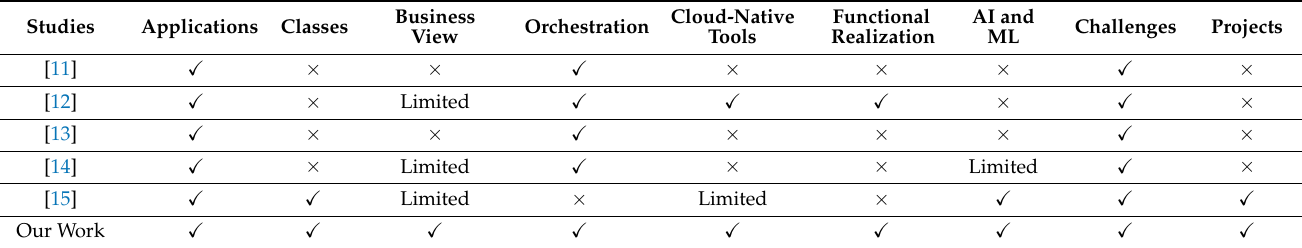
Table 2. Summary of major surveys on NS and their objectives.